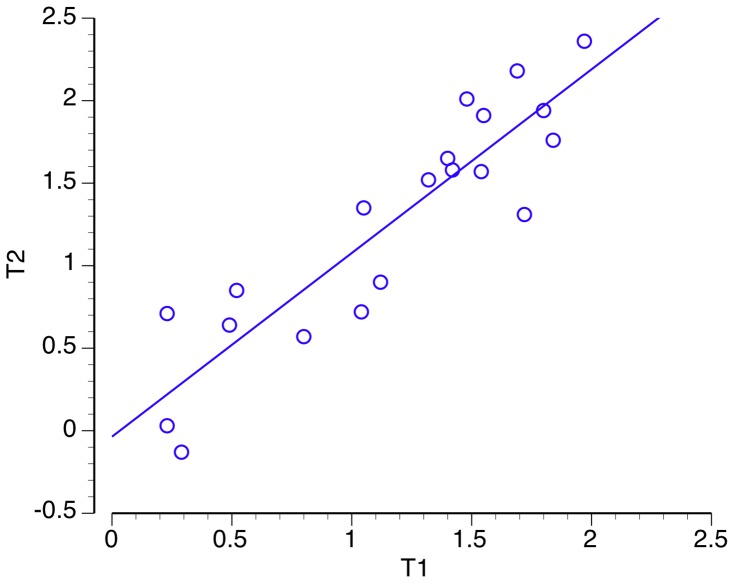
Scattergram plotting total PROMS scores at Time 1 against Time 2.Units are d prime values (d′).